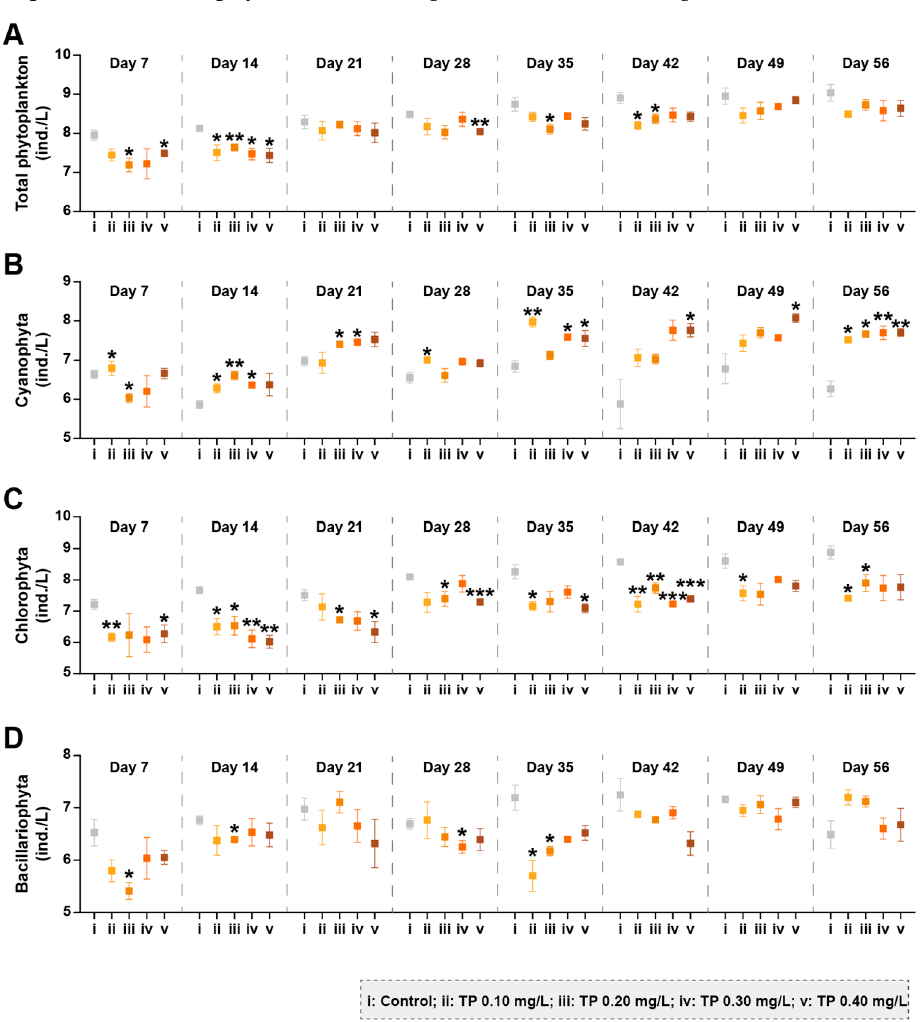
Figure 1. The abundances of phytoplankton taxa groups under different total phosphorus (TP) concentrations. ( A – D ) represents the abundance of total phytoplankton, Cyanophyta, Chlorophyta, and Bacillariophyta, respectively. The abundance data were ln(ax+1) transformed. Significant differences are indicated in the figure, p ≤ 0.05 is marked as *, p ≤ 0.01 is marked as **, and p ≤ 0.001 is marked as ***.